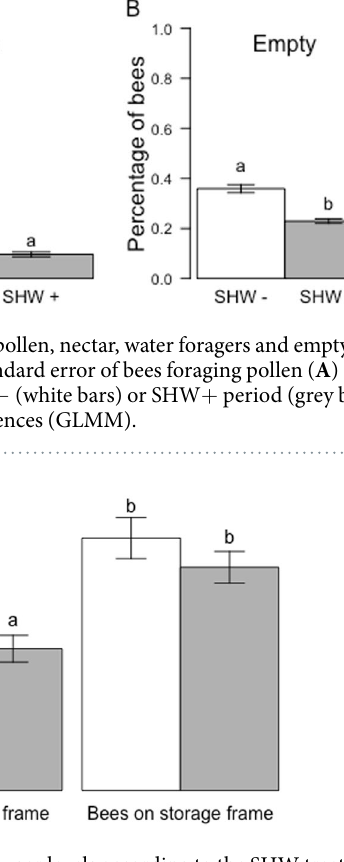
Figure 4. Haemolymph sugar levels according to the SHW treatments. Mean and standard error of sugar levels ( µ g/ µ L) in bees sampled at the end of an SHW − (white bars) or SHW + period (grey bars) (n = 53–54 bees per conditions). The sugar level was higher in bees sampled on storage frames than on brood frames (P < 0.001) but was not affected by SHW (P = 0.17). Different letters indicate significant differences